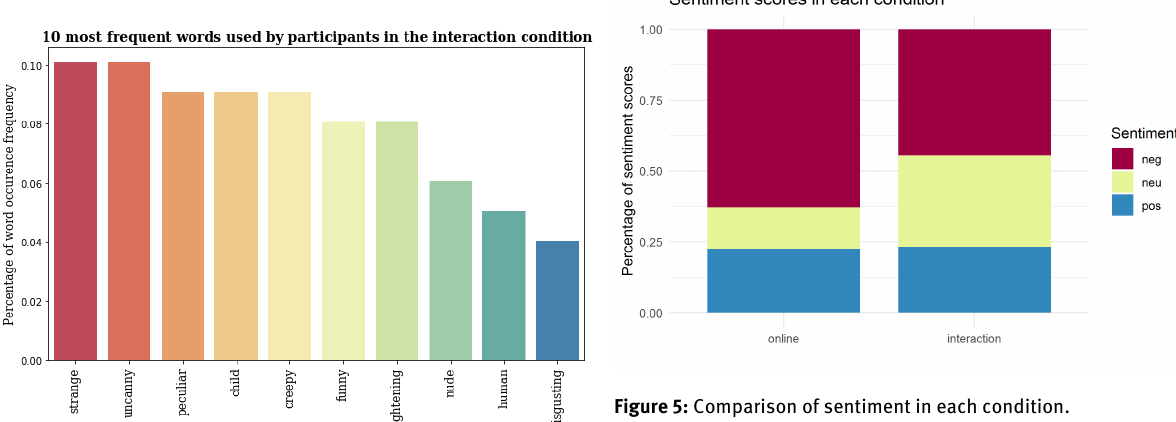
Figure 5: Comparison of sentiment in each